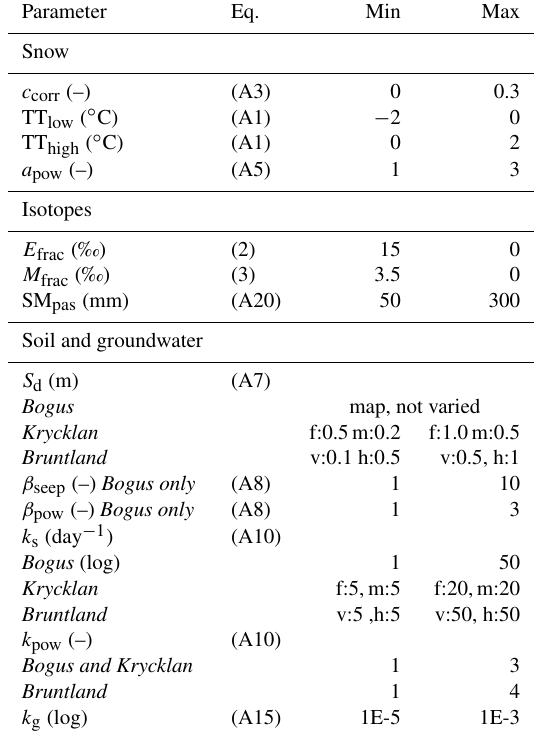
Table 1. Calibrated parameters and parameter ranges. For Brunt- land, some of the soil parameters were split into hillslopes (h) and valley bottom (v), for Krycklan between forest (f) and mire (m). For parameters which were sampled over orders of magnitudes, the parameter was log-transformed in the sampling process, which is indicated by